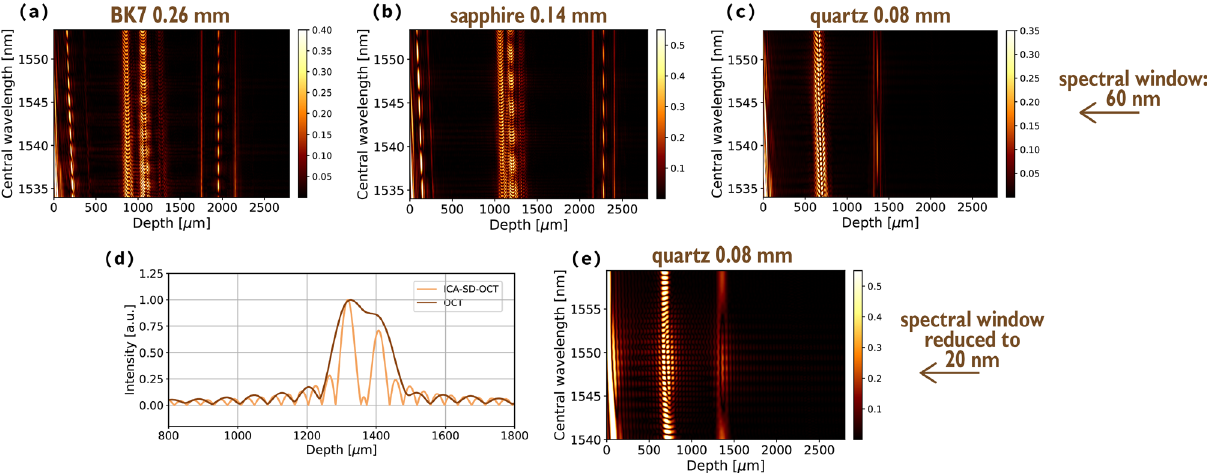
Figure 4. FFT stacks obtained with 60-nm wide fragments of an OCT spectrum for 0.26-mm thick BK7 ( a ), 0.14-mm thick sapphire ( b ) and 0.08-mm thick quartz ( c ) show that the period of the artefacts increases with a decreasing thickness. ( d ) The quartz structure is not resolved using a 20 nm wide spectrum (dark brown line), but becomes resolved when the artefacts are removed after averaging several 20-nm wide spectra (light brown line). ( e ) FFT stack of quartz corresponding to a reduced width of an individual spectrum. The intensity in ( a – c ) and ( e ) is